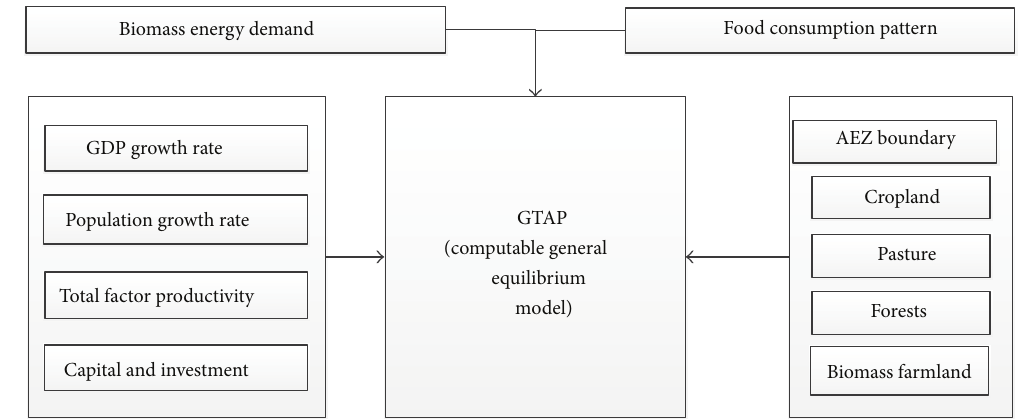
Figure 2: Framework of the GTAP-AEZ model.